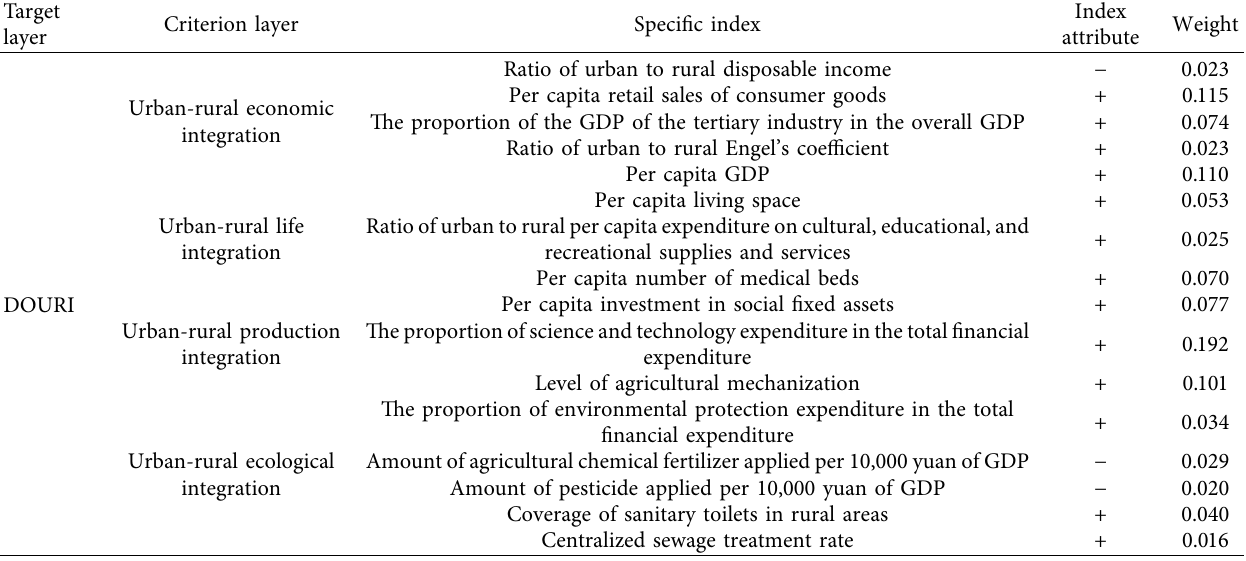
Table 1: Evaluation index system of urban-rural